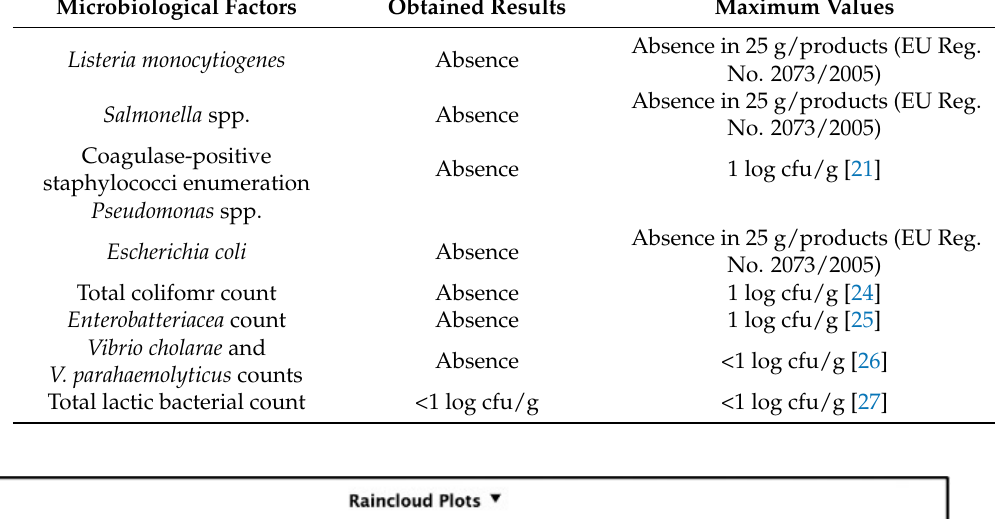
Table 5. Maximum values and relative limits of microbiological factors obtained from this study. Microbiological Factors Obtained Results Maximum Values Absence in 25 g/products (EU Reg. Listeria monocytiogenes Absence Absence in 25 g/products (EU Reg.